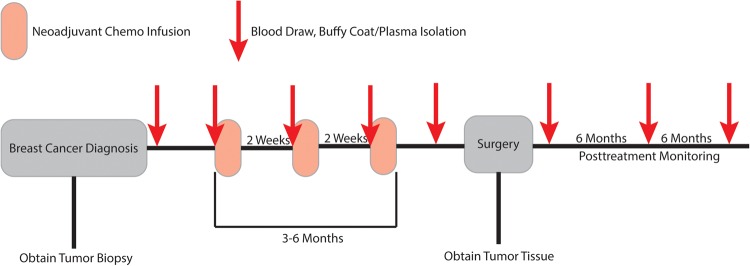
Plasma and tissue sampling strategy. Overview of study design collecting tumor tissue and plasma samples before, during, and after NAC. On-treatment plasma samples were taken in the infusion clinic before administration of drug.